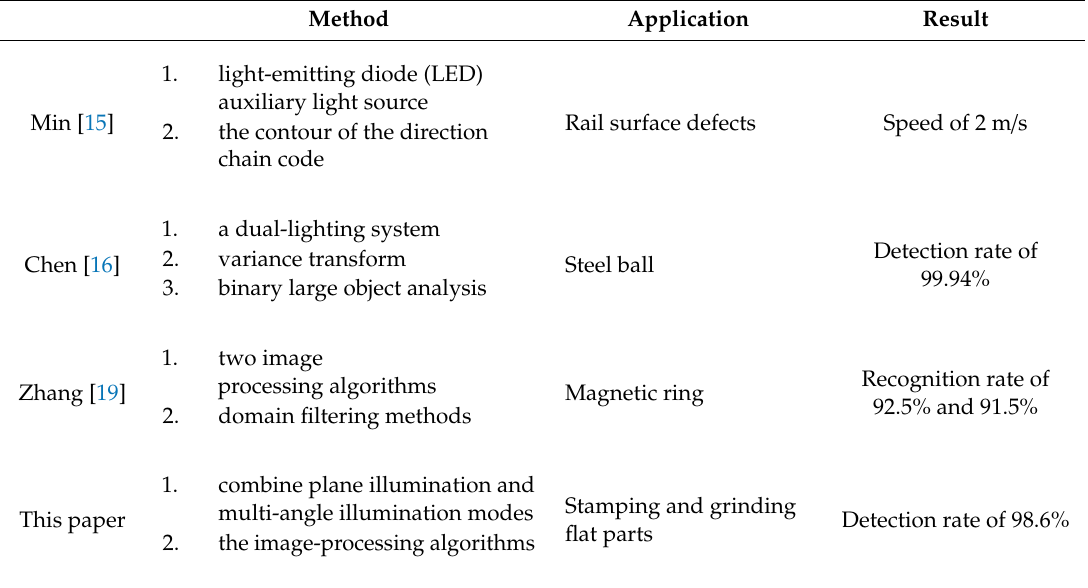
Table 1. Comparison to other works.